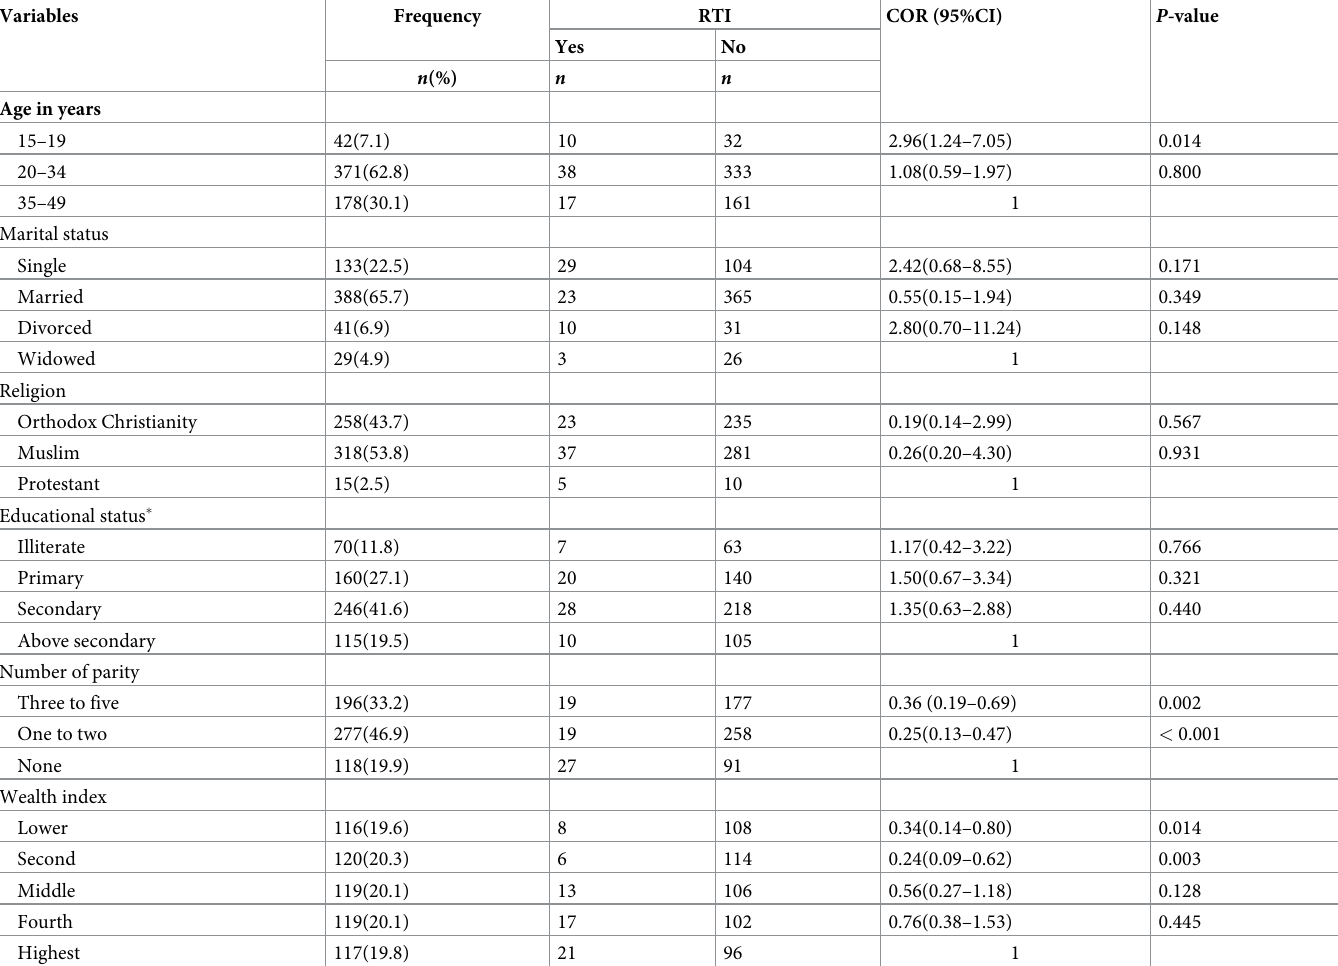
Table 1. Socio-demographic and economic characteristics of the study participants in Dessie City, Ethiopia, January to March